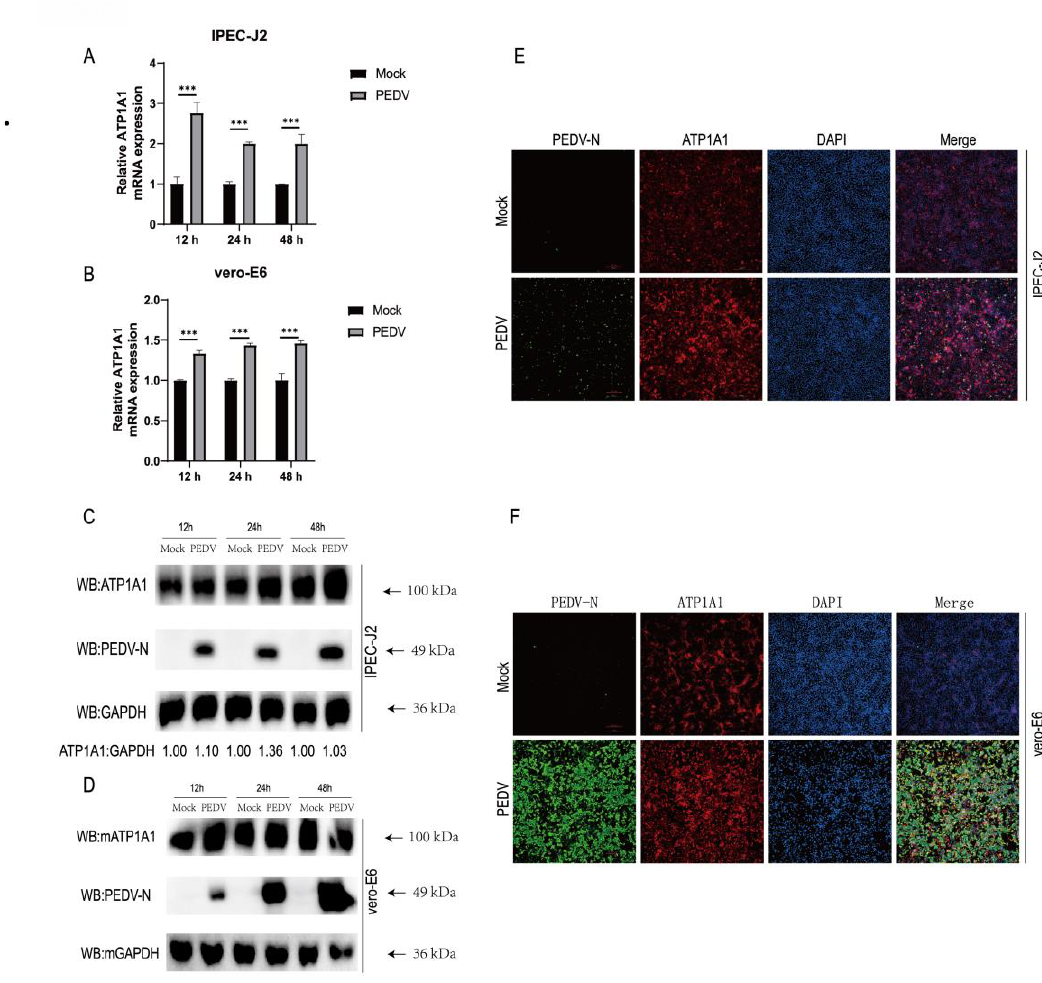
Figure 6. PEDV infection upregulates ATP1A1 protein expression in target cells. ( A,B ) PEDV infection upregulates ATP1A1 mRNA levels. IPEC-J2 and Vero-E6 cells were infected with PEDV at 0.1 MOI. At 12, 24 and 48 h, RNA was extracted, and quantitative PCR analysis performed. Data represent means ± SD from three independent experiments. ***, p < 0.001. ( C , D ) PEDV infection upregulates ATP1A1 protein expression. PEDV at 0.1 MOI infected with IPEC-J2 and Vero-E6 cells, cells were collected at the indicated time points for Western blot assay. ( E , F ) PEDV infection upregulates ATP1A1 protein expression in target cells. The cells were infected with PEDV at 0.1 MOI for 24 h. Cells were stained using triple-color immunofluorescence after fixation and analyzed using fluorescence microscopy. Scale bars, 200 µ